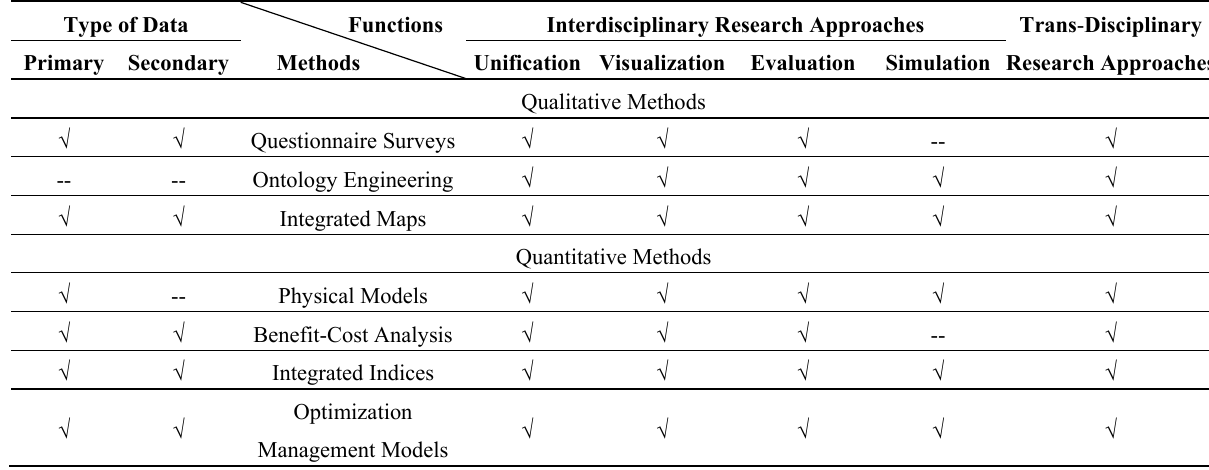
Table 2. Water-energy-food (WEF) methodology and